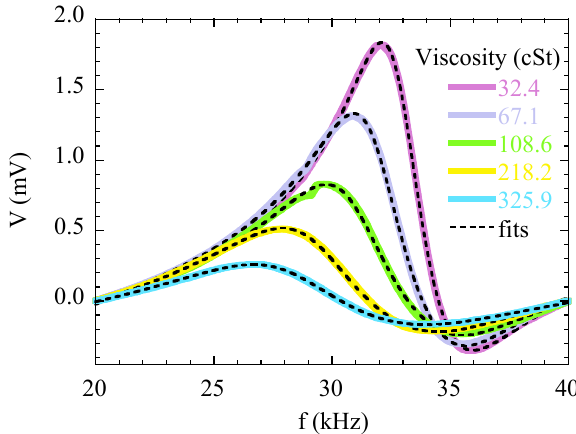
Figure 10. Magnetoelastic resonance curves measured for oils with different viscosities. The dashed lines correspond to the fitting of the experimental curves to Equation (2).